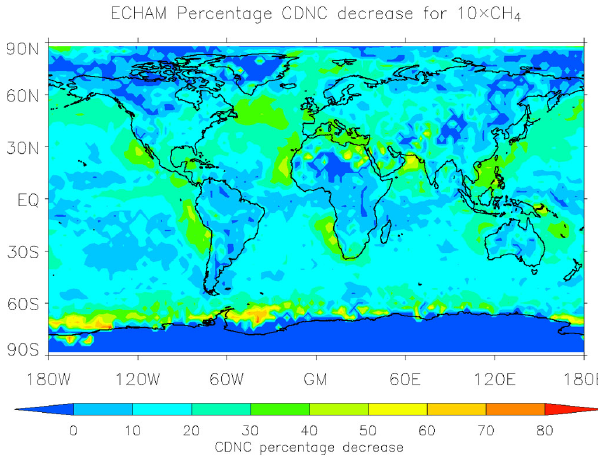
Fig. 1. Predicted aerosol radiative forcing (in Wm − 2 ) (evaluated as a difference in cloud radiative forcing) associated with a CH 4 concentration increased by a factor of 10, using ECHAM5-HAM.